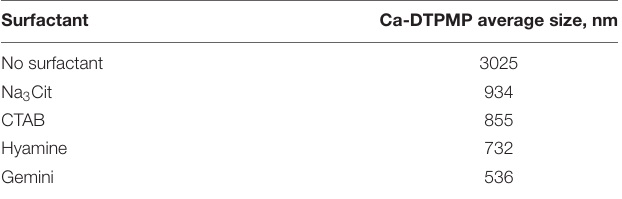
TABLE 2 | Average particle diameter sizes from DLS measurements.